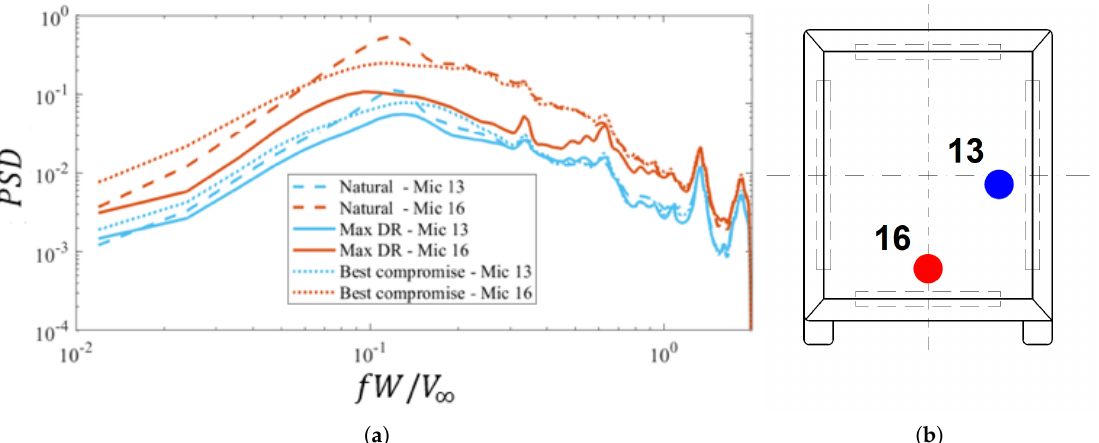
Figure 16. ( a ) Power spectral density ( PSD ) of the pressure fluctuations measured by Microphones 13 and 16 in the natural (dashed line), maximum drag reduction (continuous line) and best compromise (dotted line) cases. ( b ) Location of Microphones 13 and 16 on the model’s rear